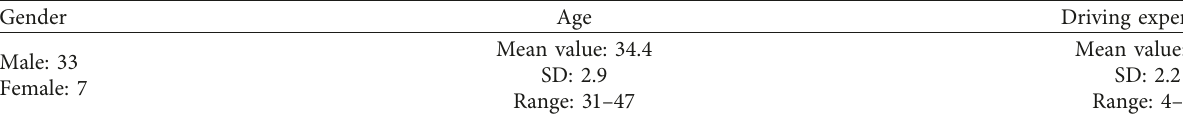
Table 1: Information of participants.